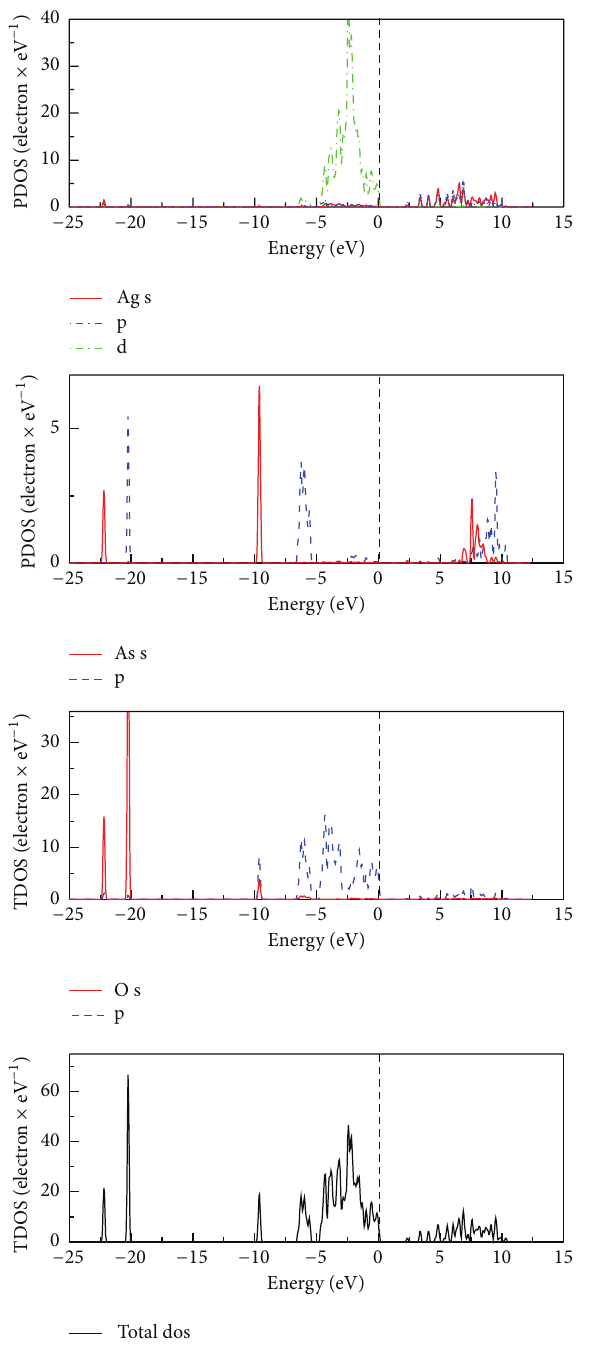
Figure 3: TDOS and PDOS of Ag 3 AsO 4 using PBE0 approach.